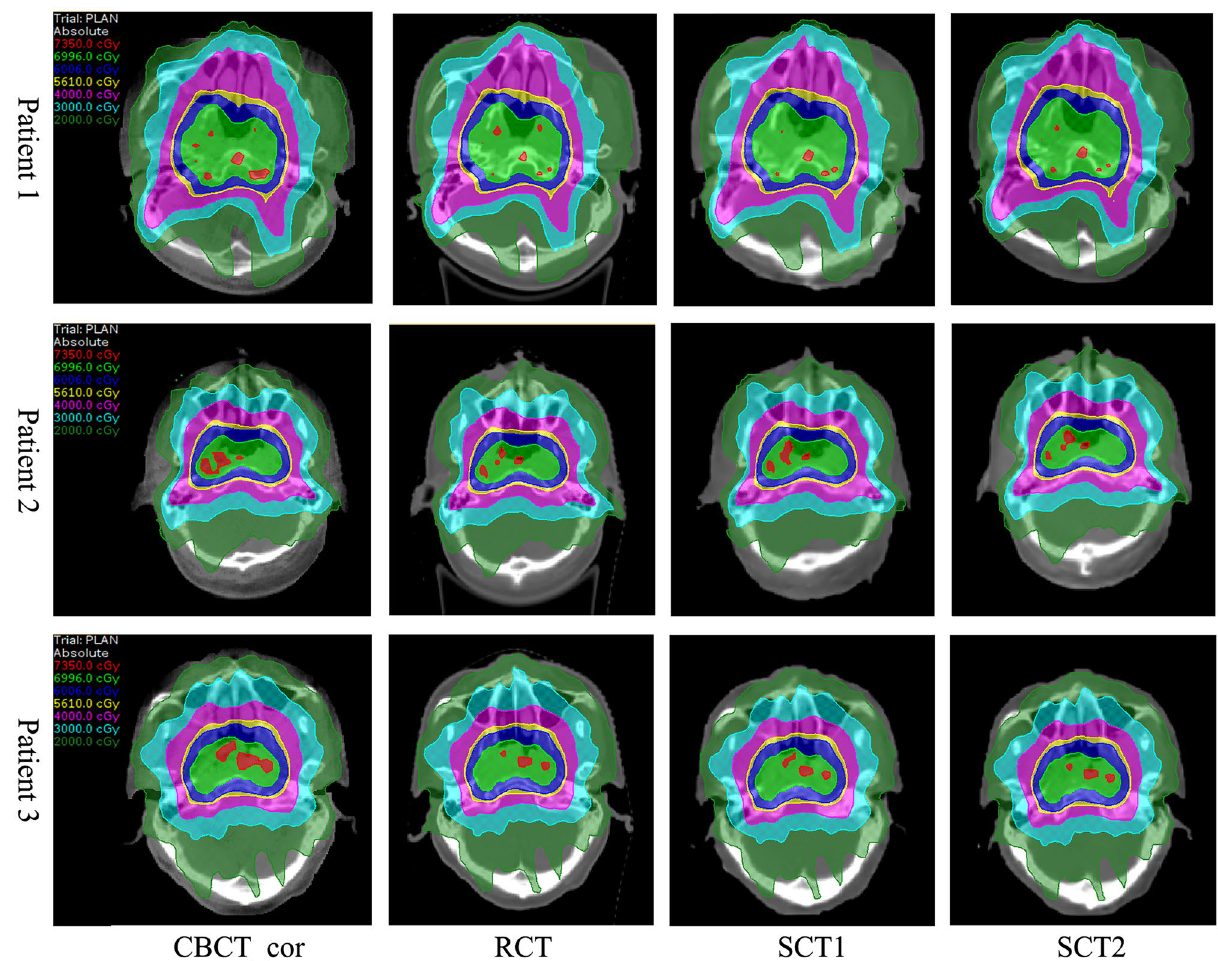
Figure 4. The dose distributions for three validation patients on CBCT_cor, RCT, SCT1 and SCT2 were